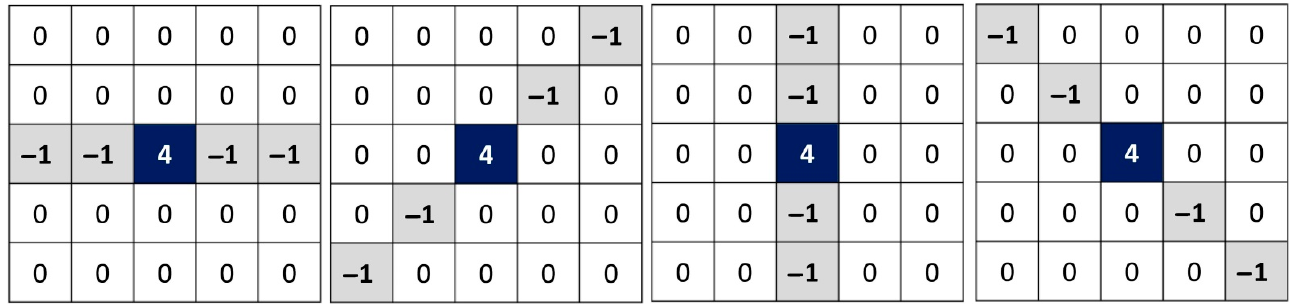
Figure 1. Two commonly used discrete approximations to the Laplacian filter.